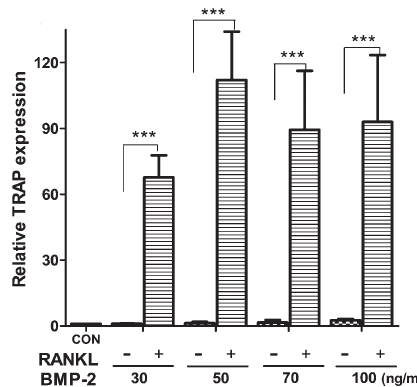
Figure 4. Effects of BMP-2 on titanium particles-mediated osteoclast formation. Real-time PCR showed the expression of TRAP. The RAW 264.7 cells were pretreated with 150 m g/mL titanium particles and different concentrations of BMP-2 for 1 h, then treated or not with 30 ng/mL RANKL for 7 days. CON: control. Data are reported as means±SD. ***P , 0.001 (one-way ANOVA).